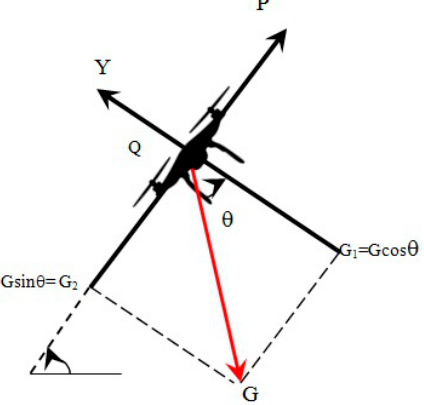
Figure 3. Schematic representation of an unmanned aerial vehicle.